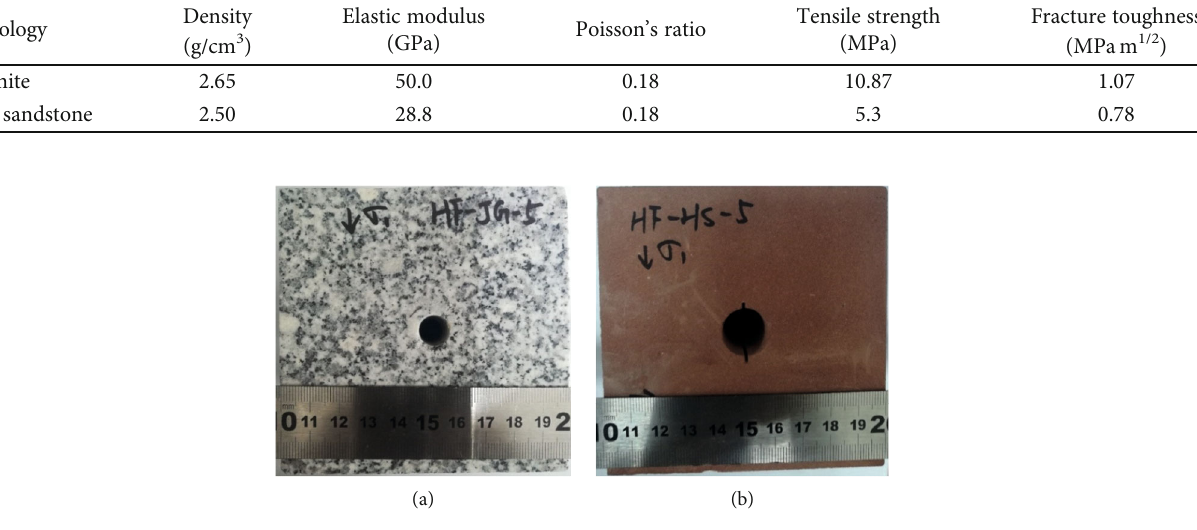
Figure 2: Typical specimens used in true triaxial HF tests. (a) Granite specimen with a through hole. (b) Through-hole red sandstone specimen with the diametrically opposed cracks. Table 2: Experiment